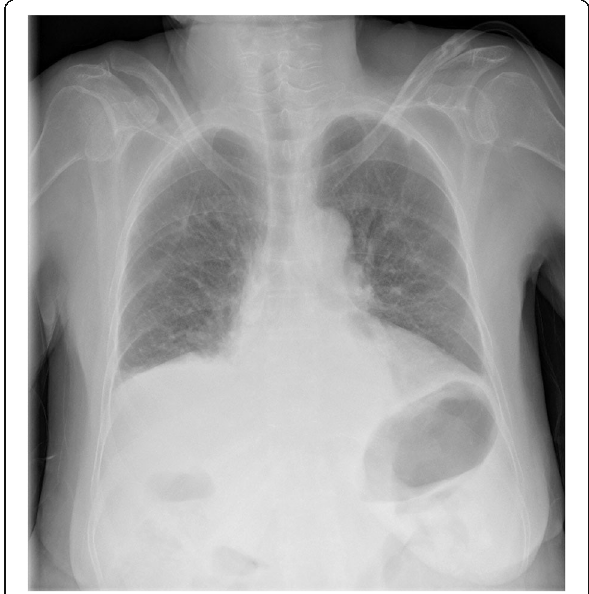
Fig. 3 Chest X-ray findings on POD 3. The right pleural effusion improved after tolvaptan administration, and no signs of pneumonia were